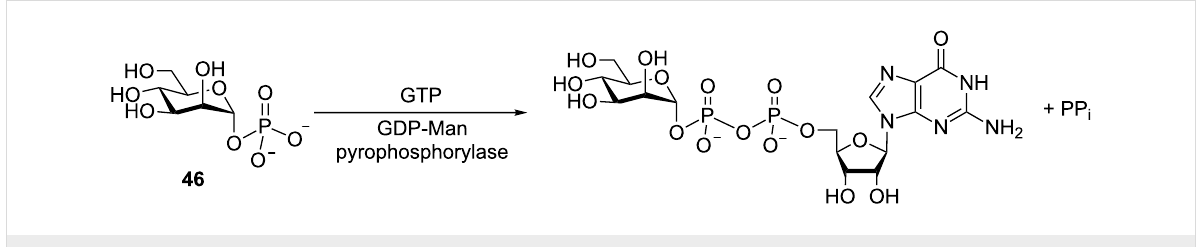
Figure 3: Reaction catalyzed by GDP-ManPP.